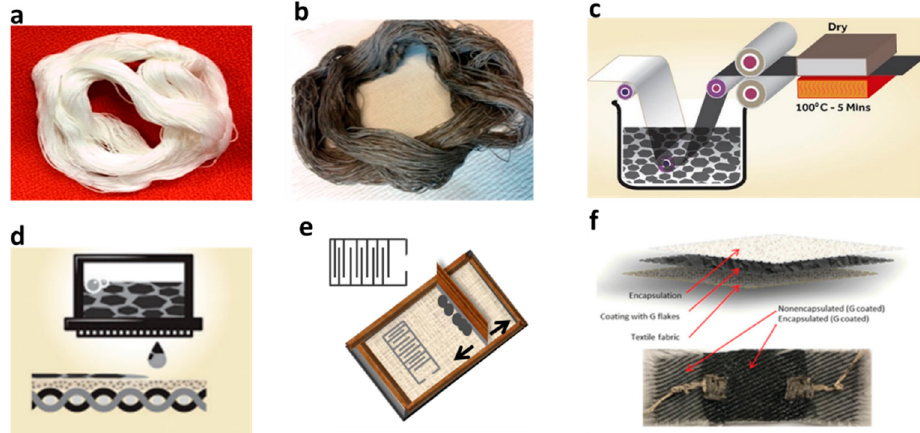
Figure 1. Scalable production of multifunctional graphene-based wearable e-textiles: ( a ) A batch of untreated cotton yarn [5], ( b ) Scalable graphene yarn via yarn dyeing technique [5], ( c ) scalable pad – dry – cure process for producing conductive graphene fabric [6], ( d ) All-inkjet- printed graphene-based wearable e-textiles [8], ( e ) Screen-printed flexible textiles supercapaci- tors [7], and ( f ) Highly conductive and machine washable graphene-based wearable e-textiles